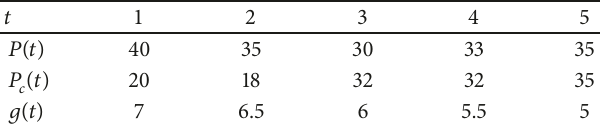
Table 1: 𝑃(𝑡) , 𝑃 𝑐 (𝑡) and 𝑔(𝑡) for 𝑡